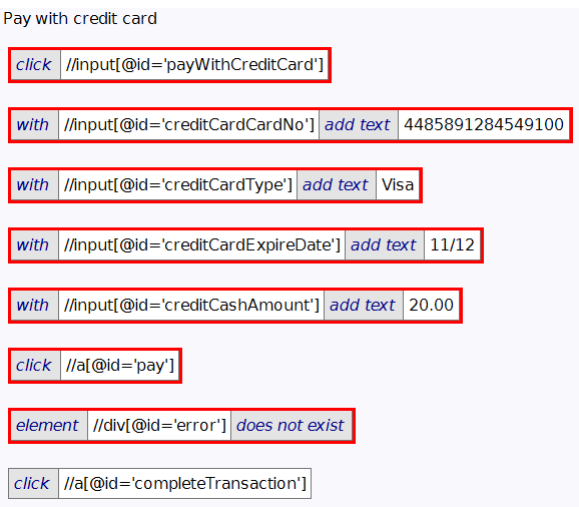
Figure 3. User selects some tables as a focus for abstracting.